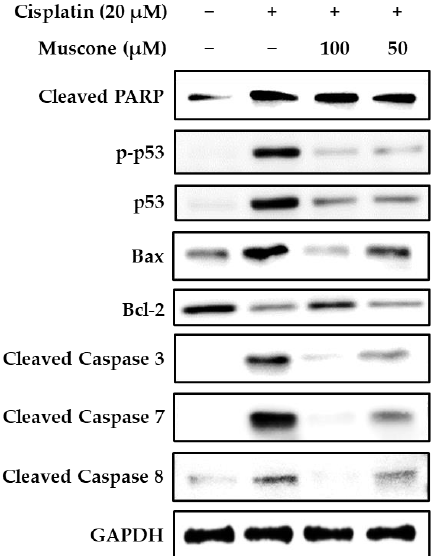
Figure 7. Effect of muscone on the expression of proteins-regulated in kidney proximal tubule LLC-PK1 cells. The cells were treated with 20 µM cisplatin and specific concentration of muscone for 24 h. Protein expression was determined by western blotting.